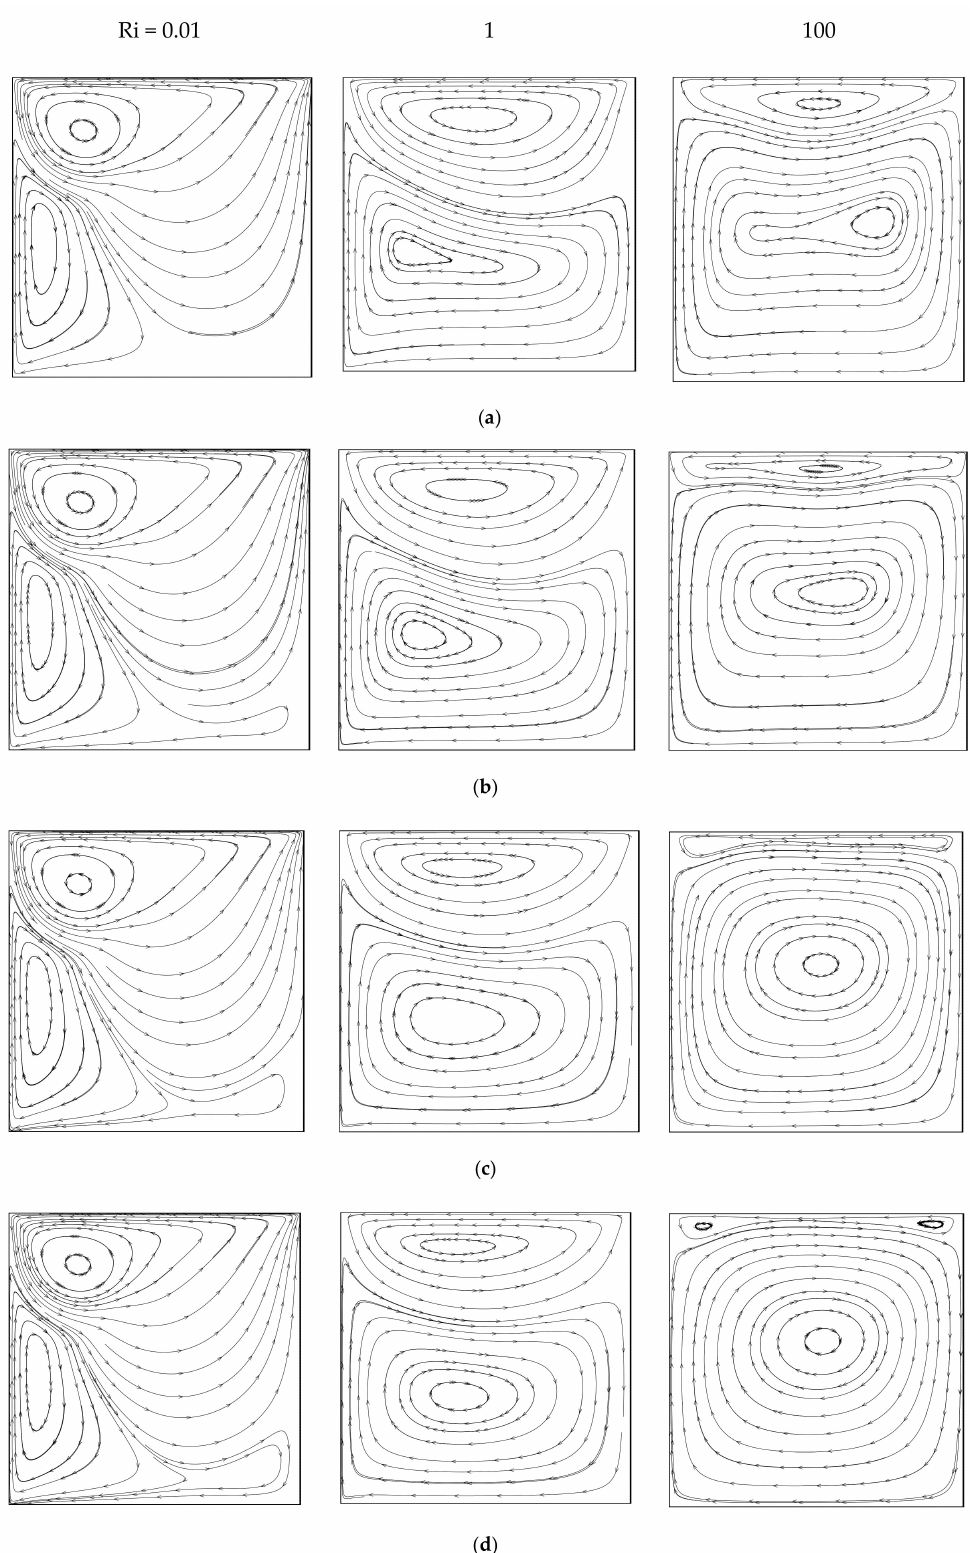
Figure 3. Streamlines for di ff erent Rd and Ri values with U 0 = − 1 (Case 2) and Φ = 0.02. ( a ) Rd = 0; ( b ) Rd = 1; ( c ) Rd = 5; ( d ) Rd =